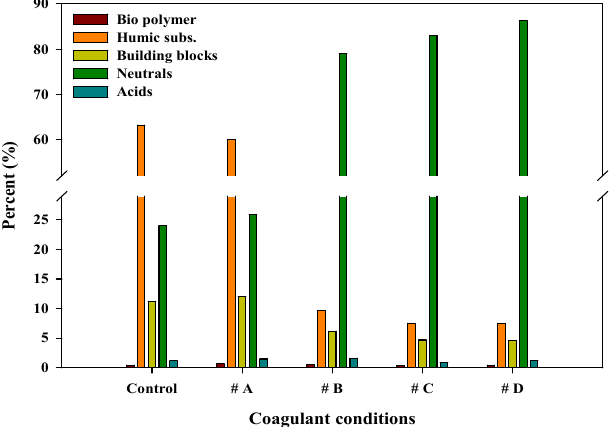
Figure 7. Composition ratio of organic matters of cleaning water under each operating condition.